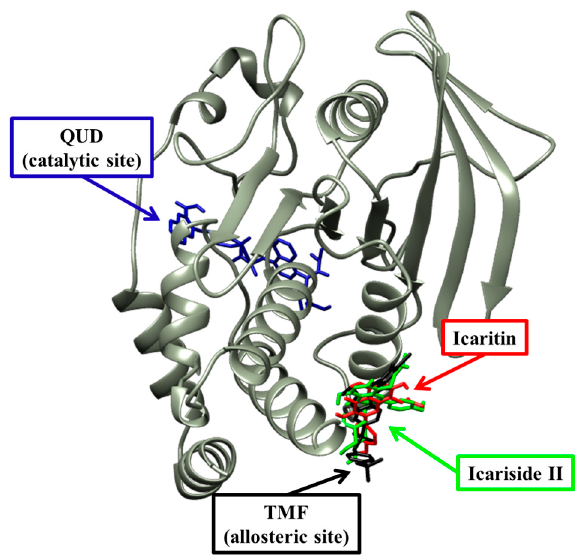
Figure 4. Molecular docking of PTP1B inhibition by compounds (compound 23 , compound 2 , icaritin and icariside II).